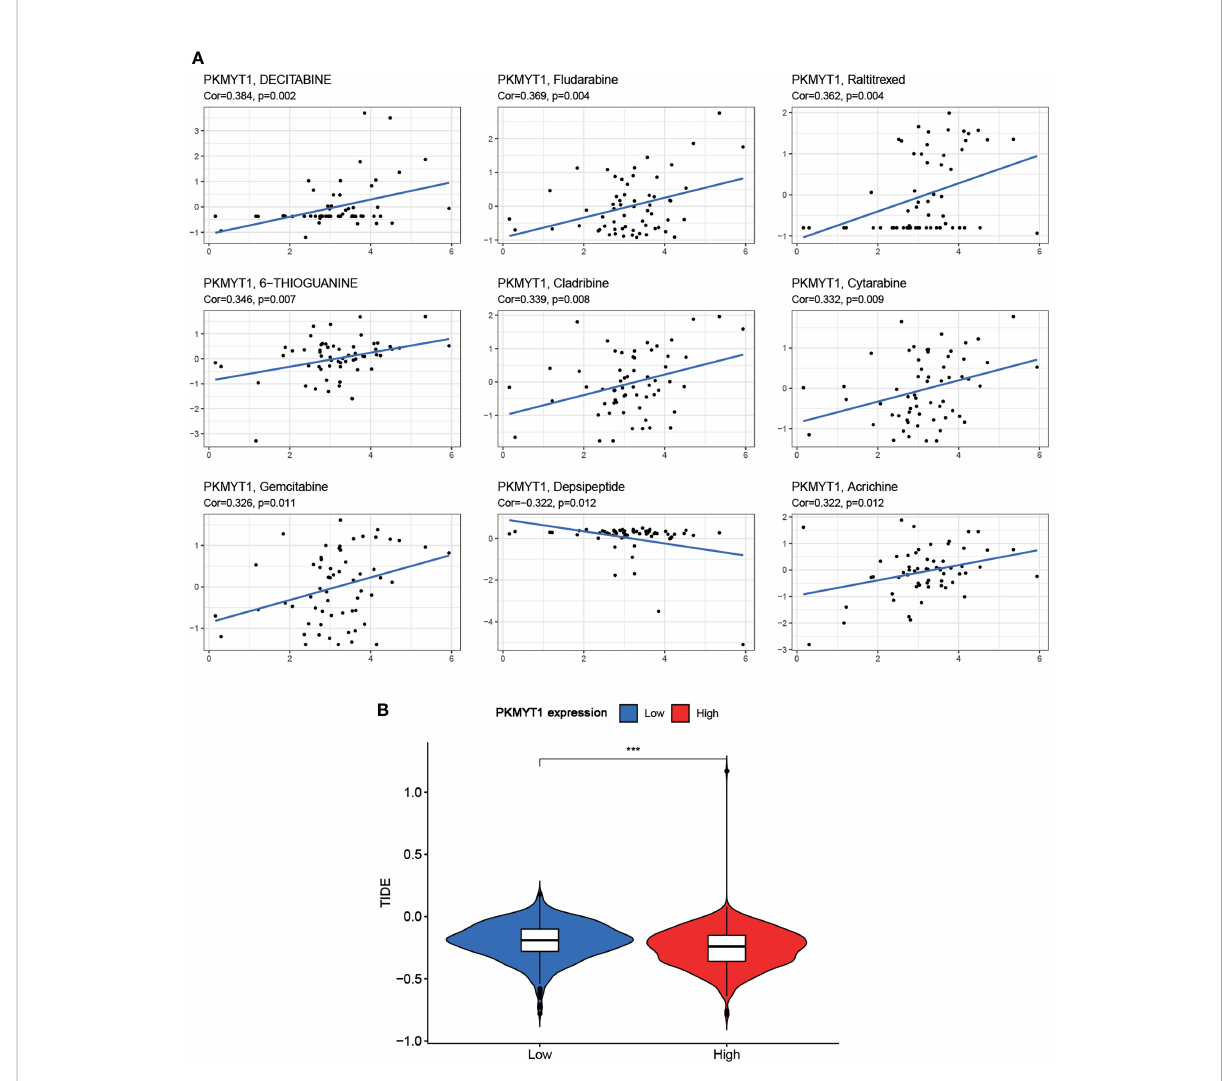
FIGURE 5 Correlation of PKMYT1 expression with the sensitivity of anticancer drugs and immunotherapy bene fi ts. (A) The PKMYT1 expression was associated with drug sensitivity of Decitabine, Fludarabine, Raltitrexed, 6-Thioguanine, Cladribine, Cytarabine, Gemcitabine, and Depsipeptide. (B) TIDE between high and low PKMYT1 expression group. *** p <